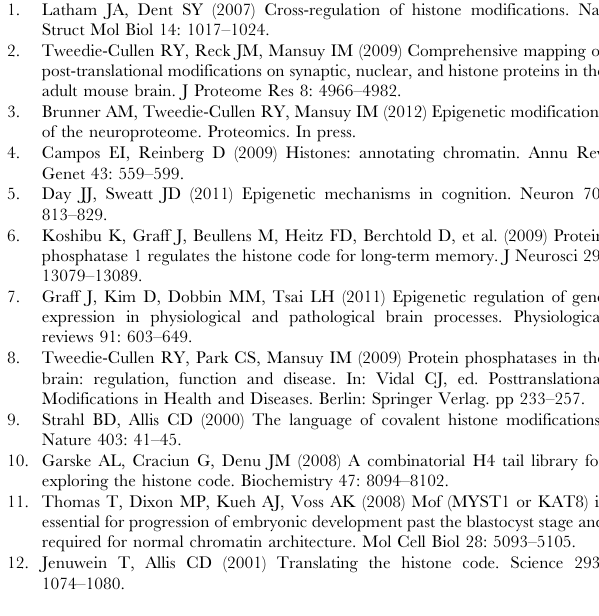
Figure S5 MS/MS spectra and ion tables of all modified peptides, i.e. those with one or more PTMs, obtained from histone digests across all experiments. The type of modification is indicated after the residue modified e.g. Sphospho for a phosphorylated serine. N-terminal acetylation is indicated by square brackets e.g. [Acetyl]. Ambiguous residues are indicated by parentheses e.g. (acetyl). Table S1 A full list of all modified peptides derived from histones that were found in all experiments. In the peptide sequence the site/s of N-terminal acetylation are designated by ‘‘ac-’’, phosphorylation by ‘‘p’’ before the modified residue, acetylation by ‘‘ac’’, , mono-/di-/tri-methylation by ‘‘me1, me2 or me3’’ respectively, propionylation by pp, and butyrylation by b after the modified residue. If the site of modification is ambiguous and cannot be assigned to a single residue, the modification is enclosed in parenthesis e.g. (p)S. Numbering of residues for the sites of modifications is as listed in Uniprot where the cleaved Met is residue 1. Modifications in manuscript text follow the usual published standard of not counting the cleaved Met residue. Table S2 A full list of all unmodified peptides derived from histones that were found in all